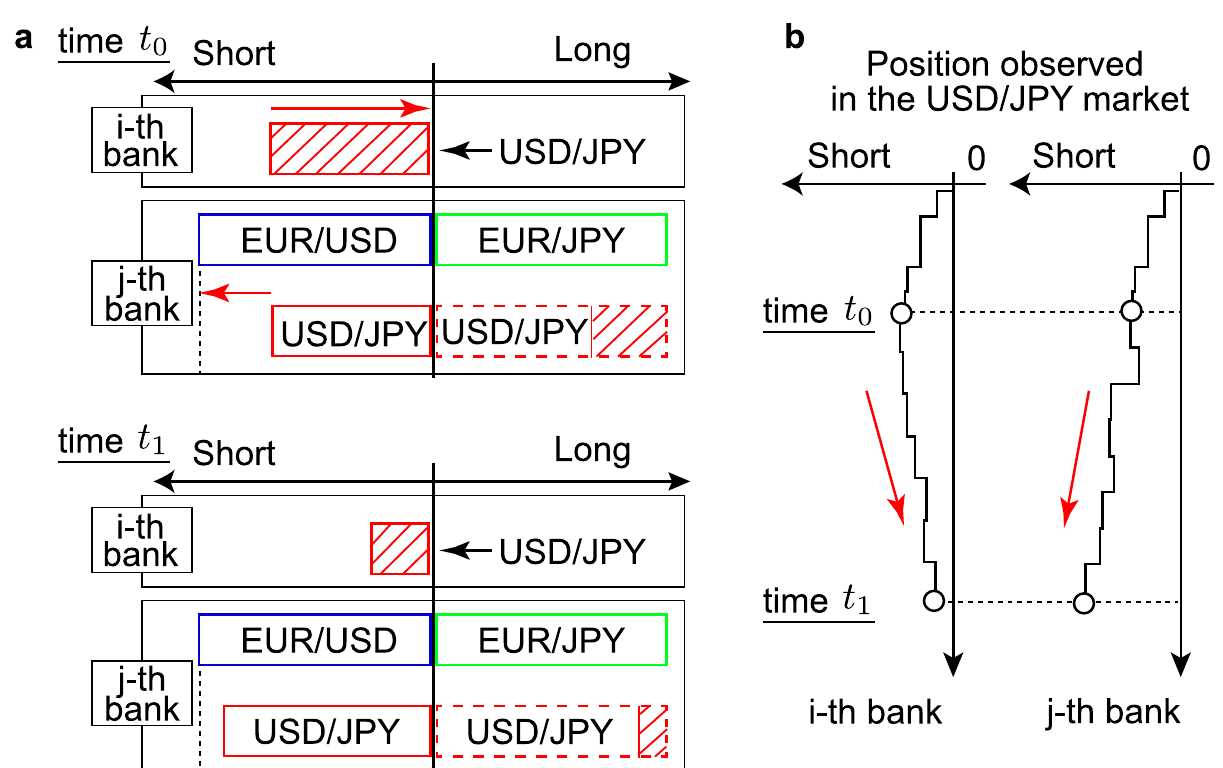
Fig 10. Schematic of the relationship between the positions of different currency pairs that banks manage and their actual exposure. (a) Position profile for the i -th bank and the j -th bank at time t 0 (top panel) and at time t 1 (bottom panel). The abscissa represents the number of short positions (left arrow) and long positions (right arrow). Assume that the i -th bank and the j -th bank have the same number of short positions in the USD/JPY market (red) at time t 0 . In addition, the j -th bank holds a short position in the EUR/USD market (blue), and a long position in the EUR/JPY market (green). The j -th bank manages three currency pairs together because the short position in the EUR/USD market and the long position in the EUR/JPY market can be reduced to a long position in the USD/JPY market (see text). We call the USD/JPY position created by using two different currency pairs an indirect position, denoted by a red dashed line in this schematic. Given the direct and indirect positions in the USD/JPY market, the actual exposure (denoted by the red oblique line) of j -th bank amounts to the difference in these positions. On the assumption that, on average, both the i -th bank and the j -th bank attempt to reduce their currency exposure, the i -th bank reduces its exposure by long contracts, whereas the j -th bank does so by entering into further short contracts, as shown at time t 1 . (b) Position trajectories in the USD/JPY market for the i -th (left) and j -th (right) bank. Despite being in the same position in the USD/JPY market until t 0 , the position trajectories differ after t 0 depending on the number of currencies the banks manage together. The trajectory of the j -th bank appears to deviate from 0, even though the bank attempts to reduce its currency